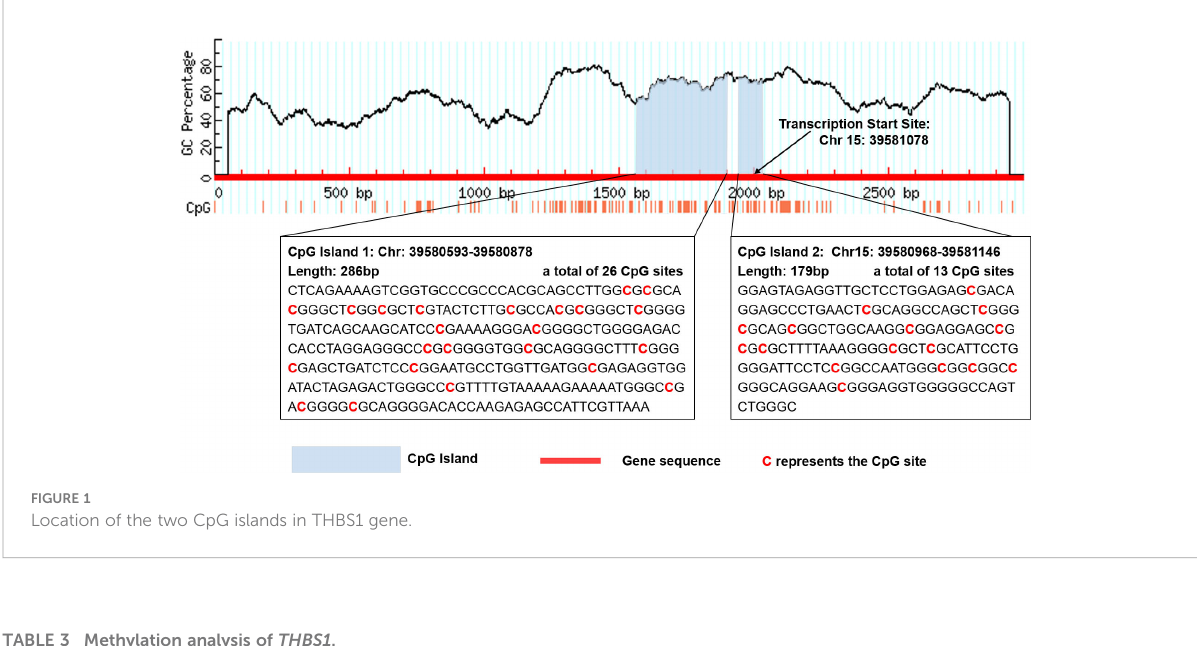
TABLE 3 Methylation analysis of THBS1